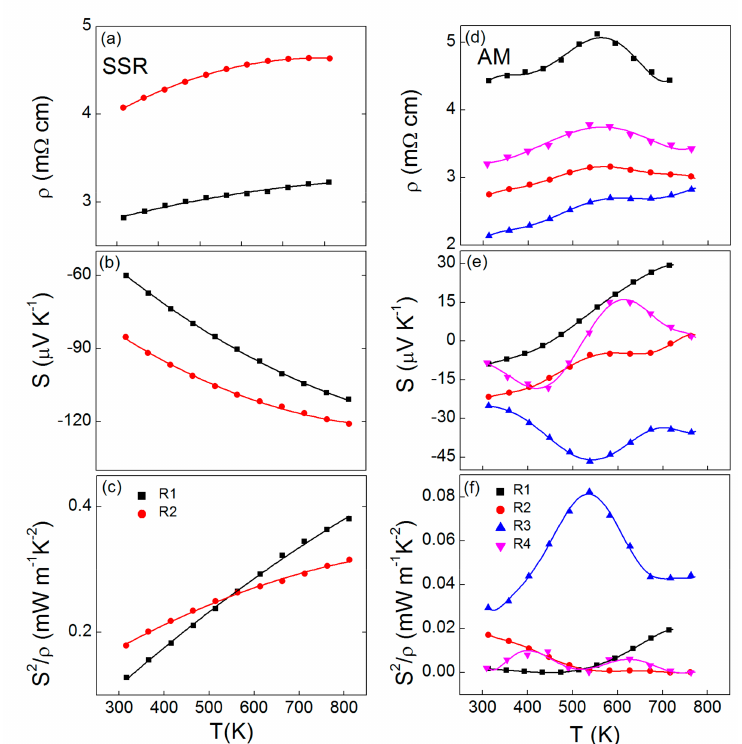
Figure 3. Temperature dependence of the electrical resistivity ( ρ ), Seebeck coefficient ( S ), and thermoelectric power factor ( S 2 / ρ ) for ( a – c ) the powder route and ( d – f ) the arc-melted Ti 0.7 V 0.3 Co .85 Fe 0.15 Sb 0.7 Sn 0.3